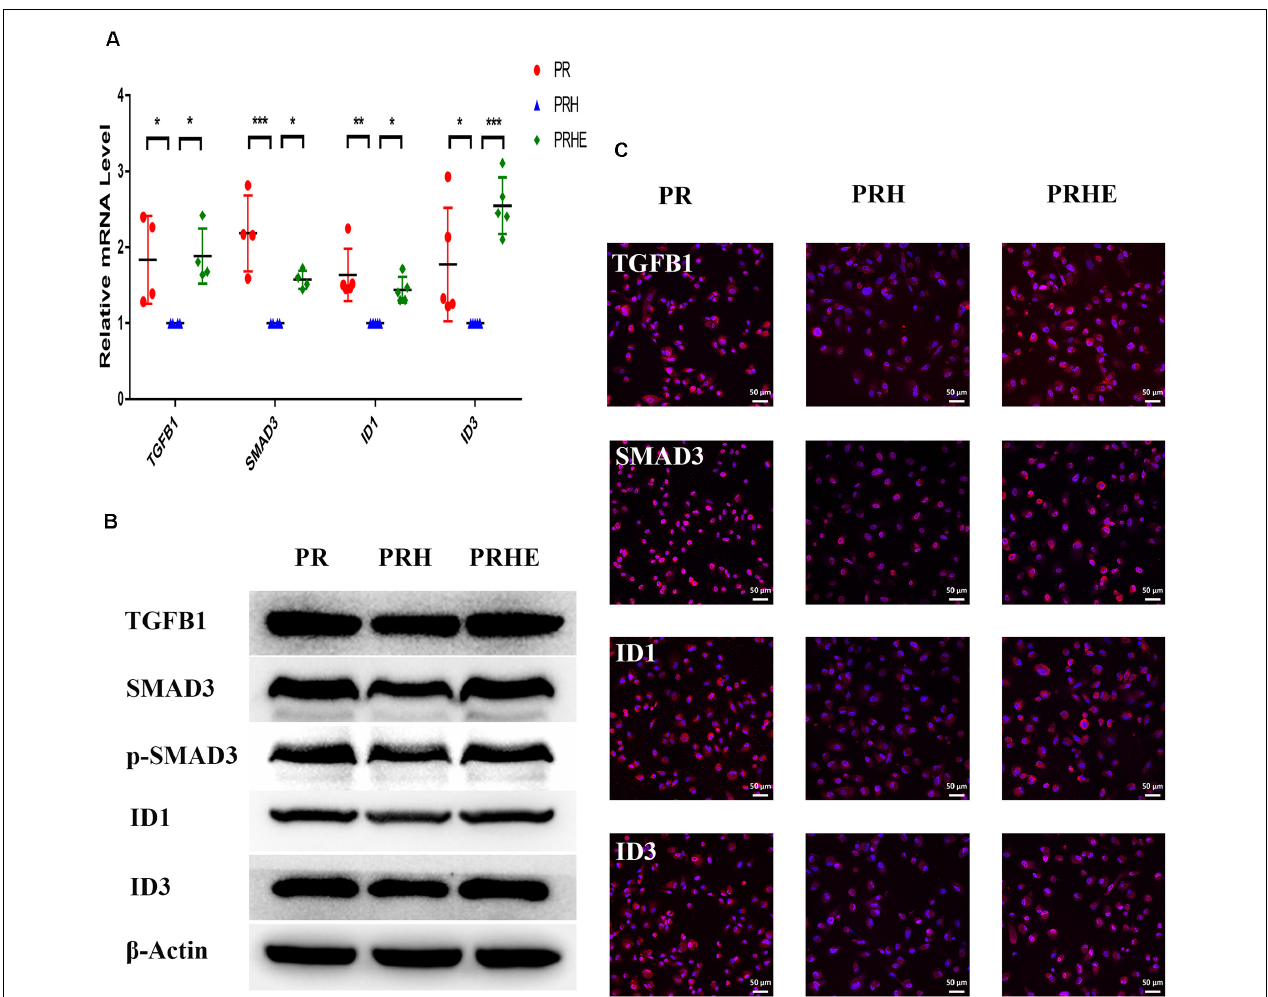
FIGURE 9 | The cocultured ESCs upregulated TGF β pathway-related markers in premature senescent RPE cells. (A) Expression of TGF β pathway-related markers in the PR, PRH, and PRHE groups, as assessed by RT-qPCR ( n ≥ 3 biological repeats). (B) Results for TGF β pathway-related markers in the PR, PRH, and PRHE groups as determined by western blotting. β -Actin was used as the internal reference. (C) The expression levels of TGF β pathway-related markers in the PR, PRH, and PRHE groups as determined by immunofluorescent staining. Scale bar, 50 µ m. Data are presented as the mean ± SD. ∗ P < 0.05; ∗∗ P < 0.01; ∗∗∗ P <